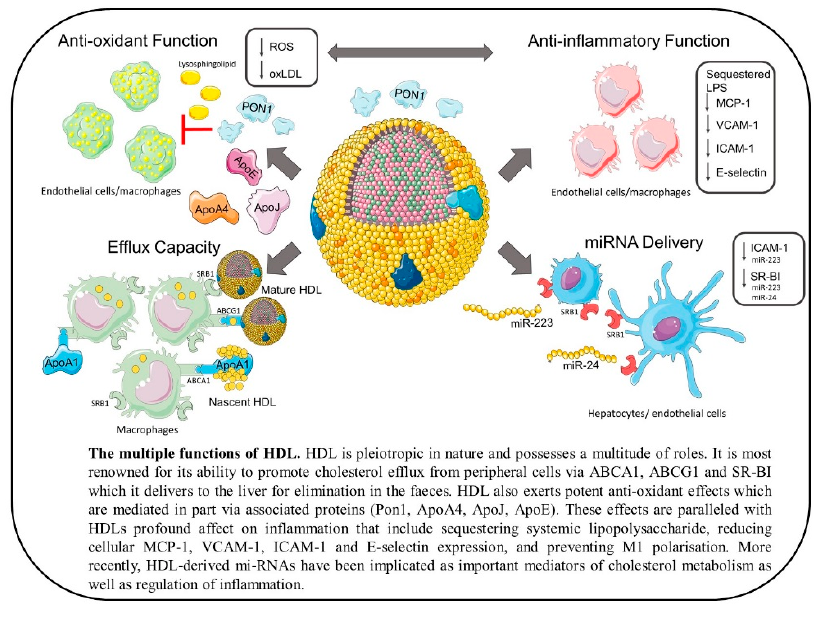
Figure 1. The multiple functions of Figure 1 . The multiple functions of HDL.